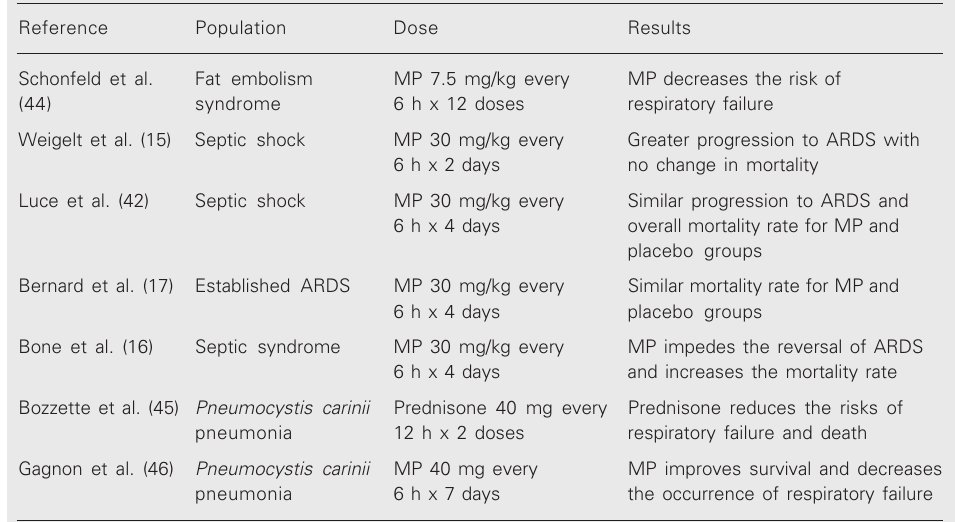
Table 1. Clinical trials of glucocorticoids for the prevention of acute respiratory distress syndrome or for the treatment of the early phase of the